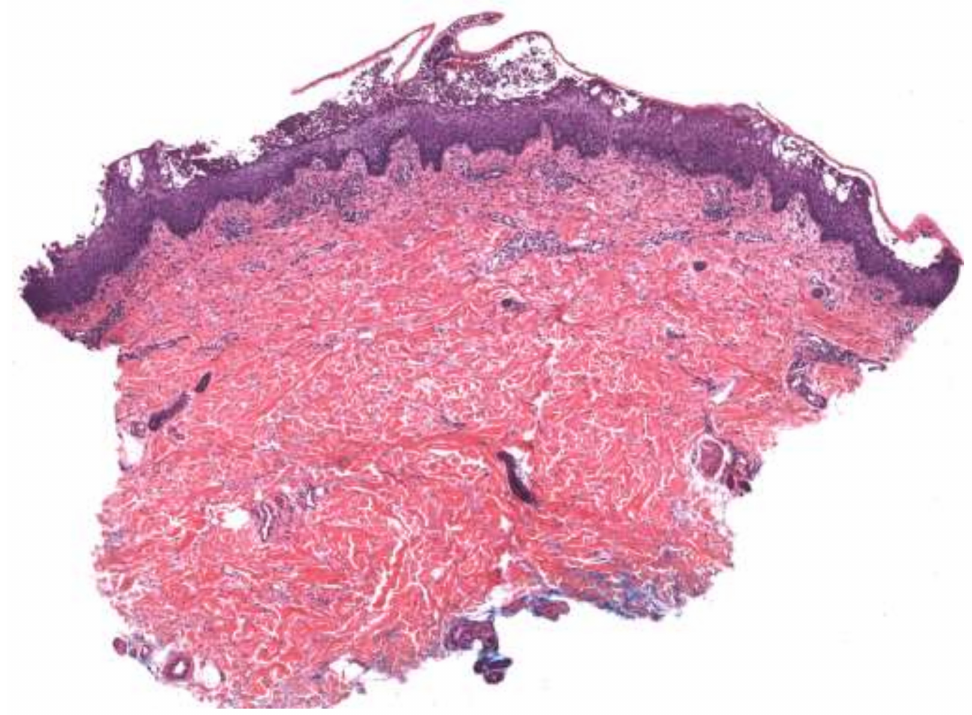
Figure 3. Generalized pustular psoriasis. Subcorneal pustular dermatitis with irregular epidermal hyperplasia and sparse dermal